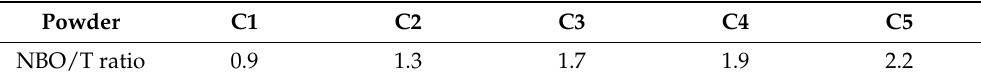
Table 3. NBO/T ratio of C-series mould powder used in this